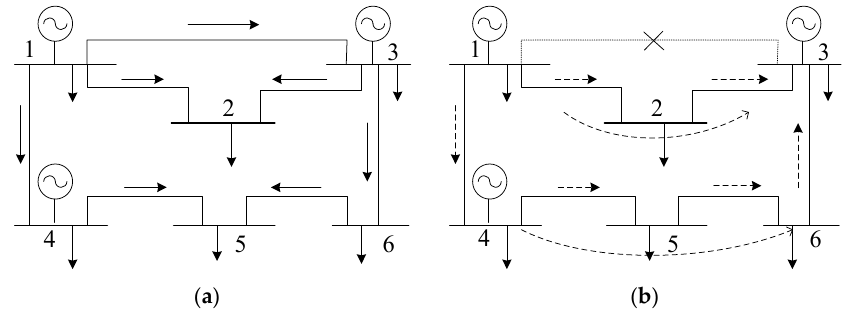
Figure 2. ( a ) Power flow of the 6-bus system in normal operation; ( b ) The redistribution of power flow caused by the removal of line 1–3.